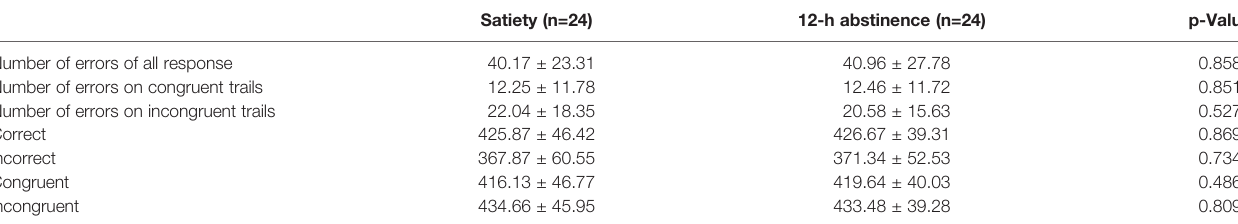
Values are expressed as means ± standard